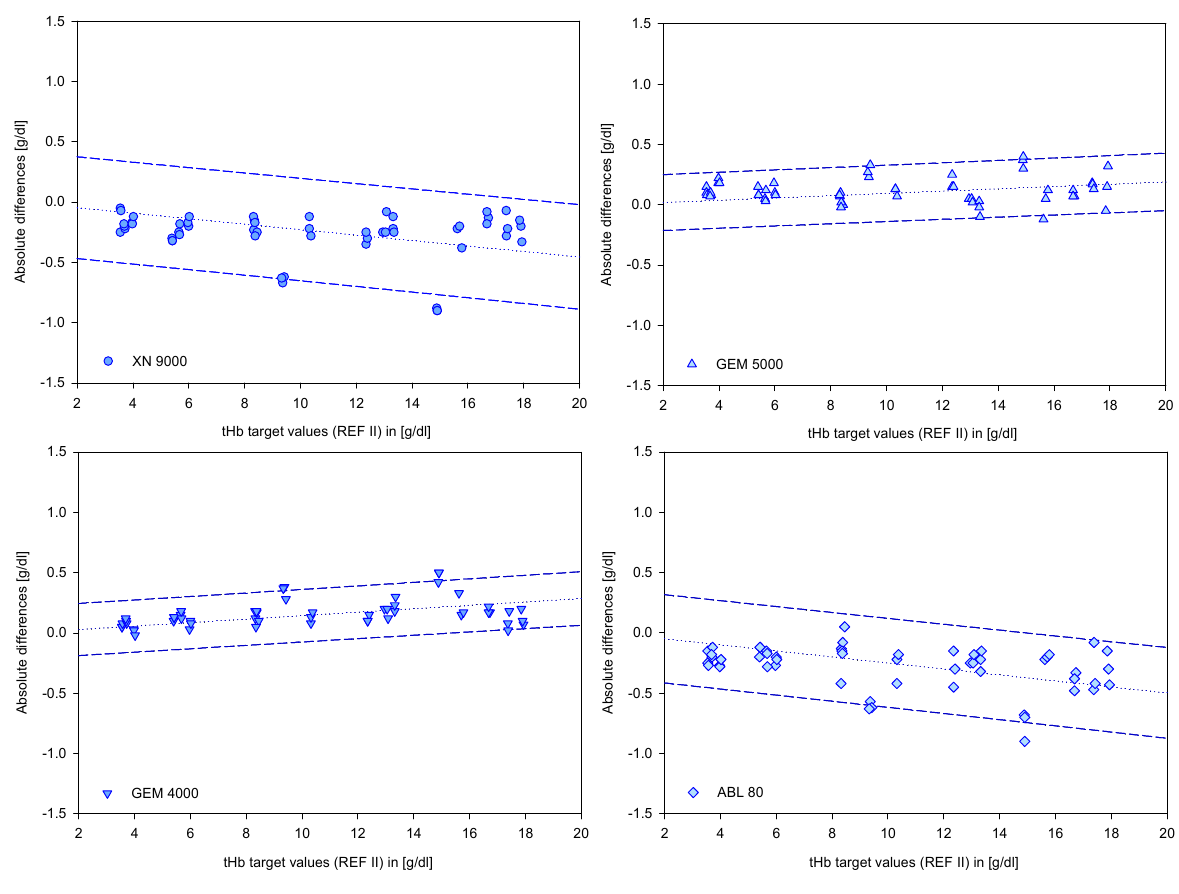
Figure 4. Prediction regression lines with the 95 % prediction intervals of the clinically relevant devices. The graphs show data points from the clinically relevant devices versus target values (REF II).